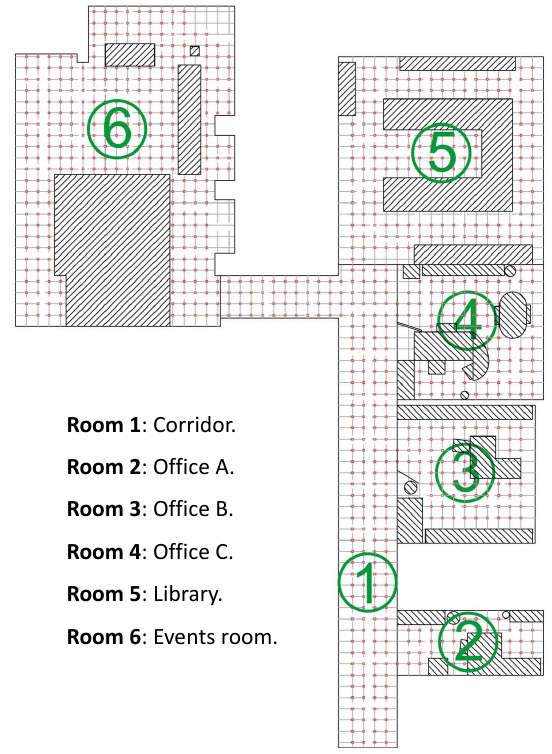
Figure 4. Bird’s eye view of the Quorum V